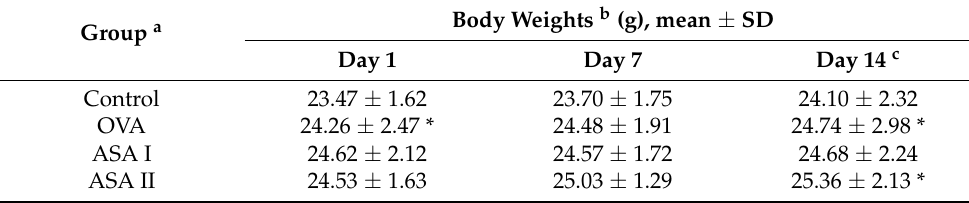
Table 1. Body weights of mice at different intervals of experiment during intradermal (i.d.) adminis- tration for systemic response.